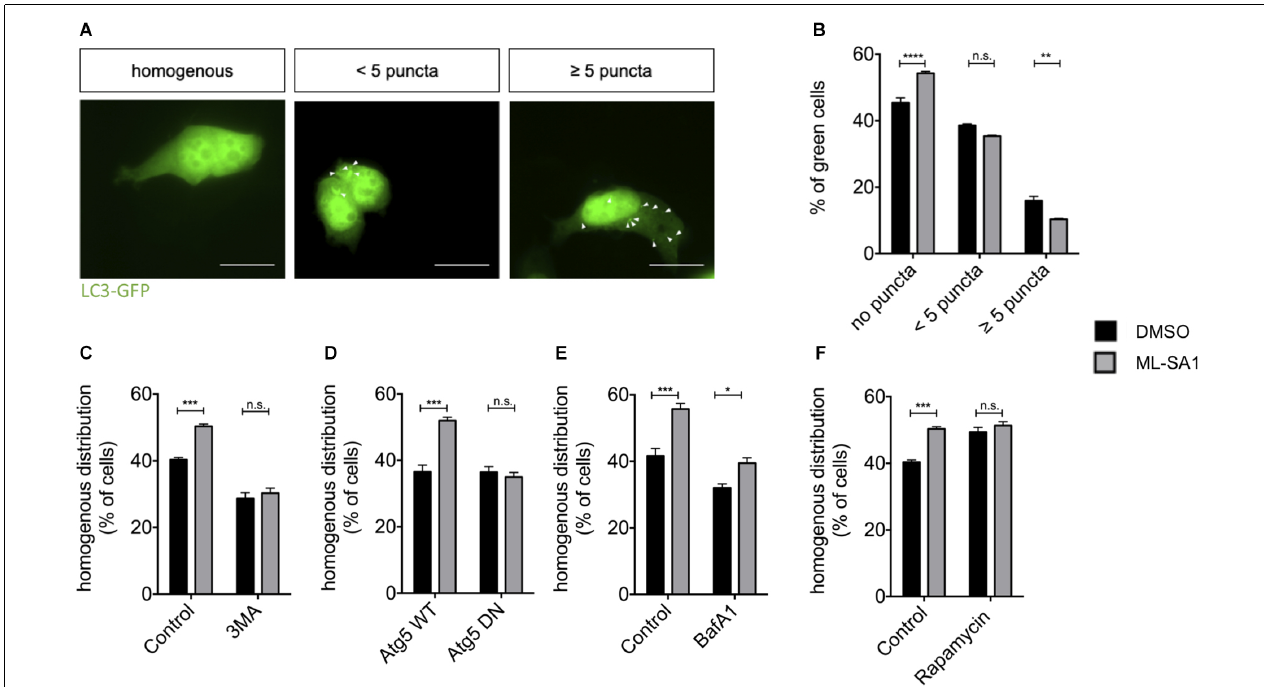
FIGURE 4 | TRPML1-Agonist ML-SA1 promotes autophagy. (A) HEK293T cells were transfected with the autophagosome marker LC3-GFP and treated with 25 µ M ML-SA1 or DMSO starting 6 h after transfection for 18 h. Example images of possible distribution of LC3 in the cell are shown (white arrows). Scale bars represent 20 µ m. (B) Quantitative analysis from n = 3 independent experiments as described in (A) showing the frequency of cells with a homogenous distribution of GFP, cells with less than five puncta, and cells with more than five puncta. Two-way ANOVA (factors phenotype and ML-SA1-treatment) showed a significant interaction ( p < 0.0001). Sidak’s multiple comparisons test is depicted with respect to DMSO (control). (C) HEK293T cells expressing GFP-tagged A53T- α -synuclein were treated with 25 µ M ML-SA1, 2 mM 3-MA, both or DMSO only starting 6 h after transfection for 18 h. Results of n = 3 independent experiments. Two-way ANOVA (factors 3-MA-treatment and ML-SA1-treatment) showed significant interaction ( p < 0.0001). Sidak’s multiple comparisons test is depicted with respect to DMSO (control). (D) HEK293T cells were transfected with GFP-tagged A53T- α -synuclein and either ATG5 WT or ATG5 DN and treated as described above. Percentage of cells with homogenous GFP distribution from n = 3 independent experiments. Two-way ANOVA (factors WT vs. DN Atg5 transfection and ML-SA1-treatment) showed significant interaction ( p < 0.0001). Sidak’s multiple comparisons test is depicted with respect to DMSO. (E) HEK23T cells transfected with GFP-tagged A53T- α -synuclein and treated 6 h after transfection with 25 µ M ML-SA1, 5 nM Bafilomycin A1, both or DMSO only for 18 h. Quantitative analysis of n = 3 independent experiments is represented. Two-way ANOVA (factors Bafilomycin-A1-treatment and ML-SA1-treatment) showed no significant interaction ( p = 0.088), in line with significant differences regarding the treatment (ML-SA1: p < 0.0001; BafA1: p = 0.0002). (F) HEK293T cells were transfected with GFP-tagged A53T- α -synuclein and treated with either 25 µ M ML-SA1, 100 nM rapamycin, both or DMSO only starting 6 h after transfection for 18 h. Quantitative analysis from n = 3 independent experiments showing the frequency of cells with a homogenous distribution of GFP. Two-way ANOVA (factors ML-SA1-treatment and rapamycin-treatment) showed significant interaction ( p = 0.005). Sidak’s multiple comparisons test is depicted with respect to DMSO (control). * p < 0.05, ** p < 0.01, *** p < 0.001, **** p < 0.0001, non-significant differences are depicted as